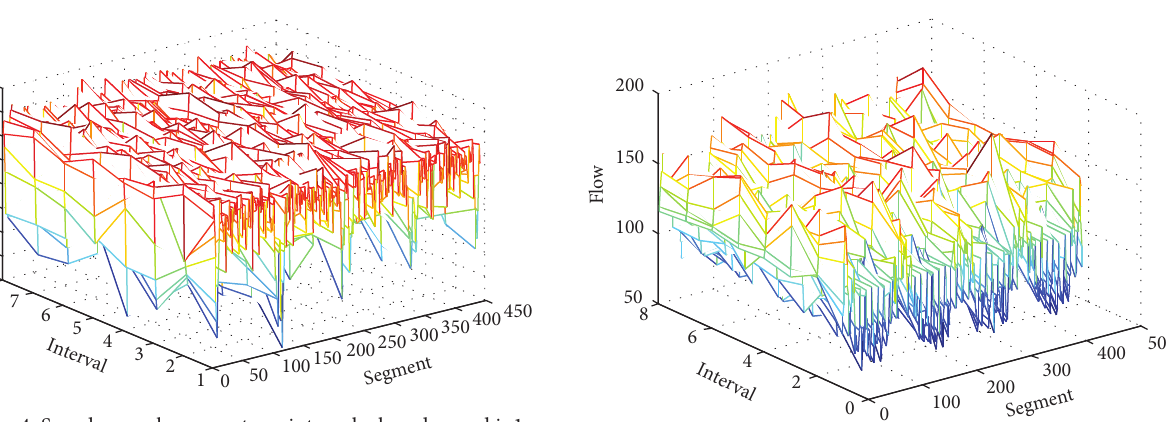
Figure 4: Speed on each segment per interval when demand is 1.